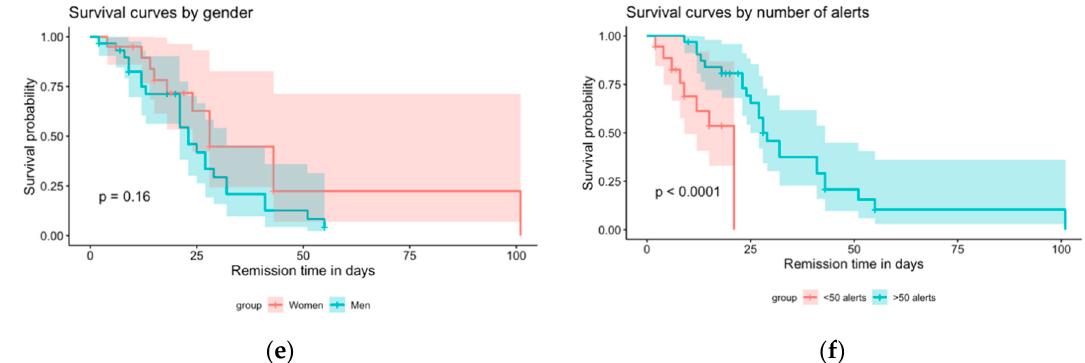
Figure 2. Survival analysis. ( a ): Survival curves by gender following cardiac decompensation. ( b ): Survival curves by number of alerts following cardiac decompensation. ( c ): Survival curves by gender following alteration of general health. ( d ): Survival curves by number of alerts following alteration of general health. ( e ): Survival curves by gender following other reason. ( f ): Survival curves by number of alerts following other reason.